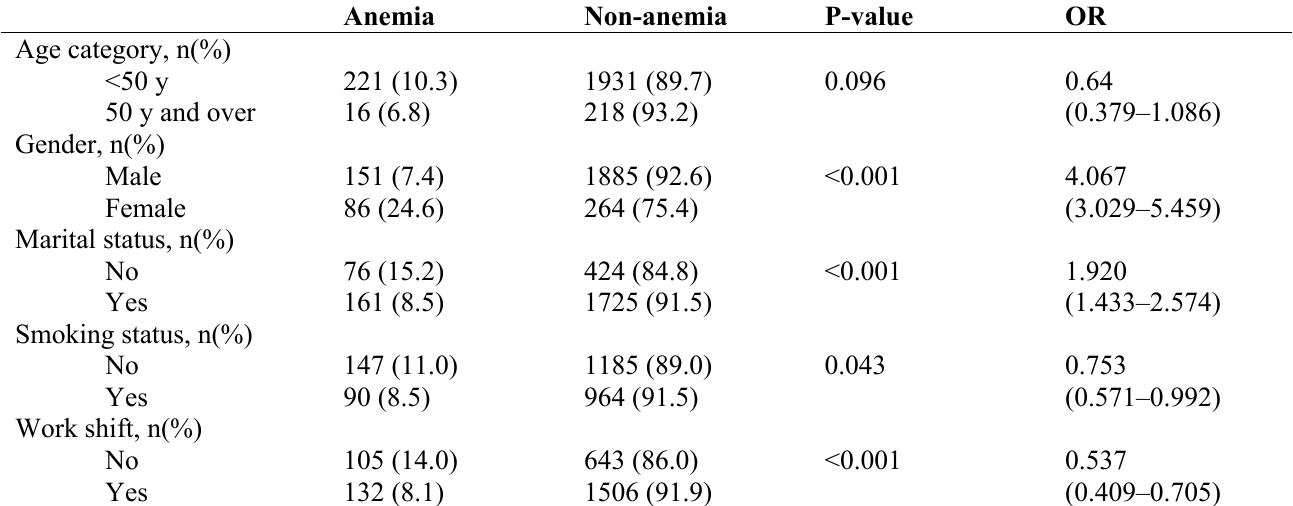
Table 3. Associations between anemia status and subjects’ characteristics (n =